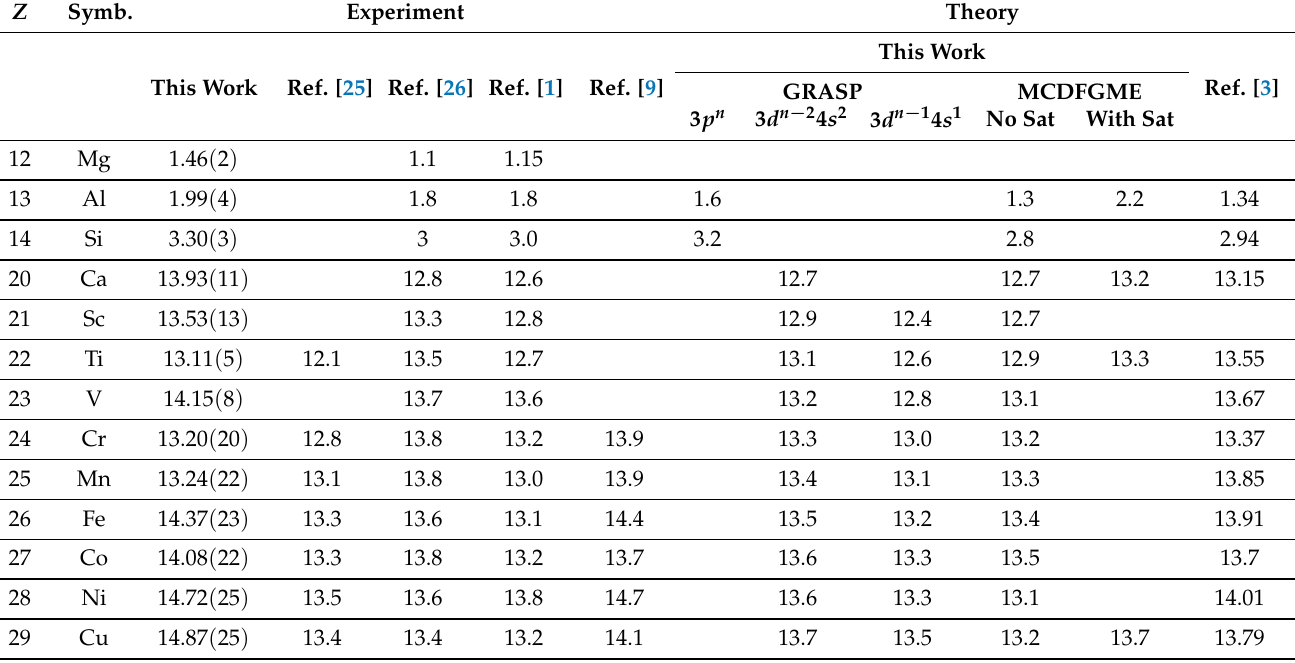
for the K β 1,3 lines is 0.904. The detection efficiency ratio D ( K β / K α ) is therefore 1.04. The self-absorption ratio S ( K β / K α ) 0.756 for each of those lines, and the reflection intensity ratio R 2 ( K β / K α ) 1.17 for two reflections. The correction value is therefore 0.1487. The correction values for the other elements were obtained using this procedure. Table 1. K β / K α intensity ratio, in %. See text for details.